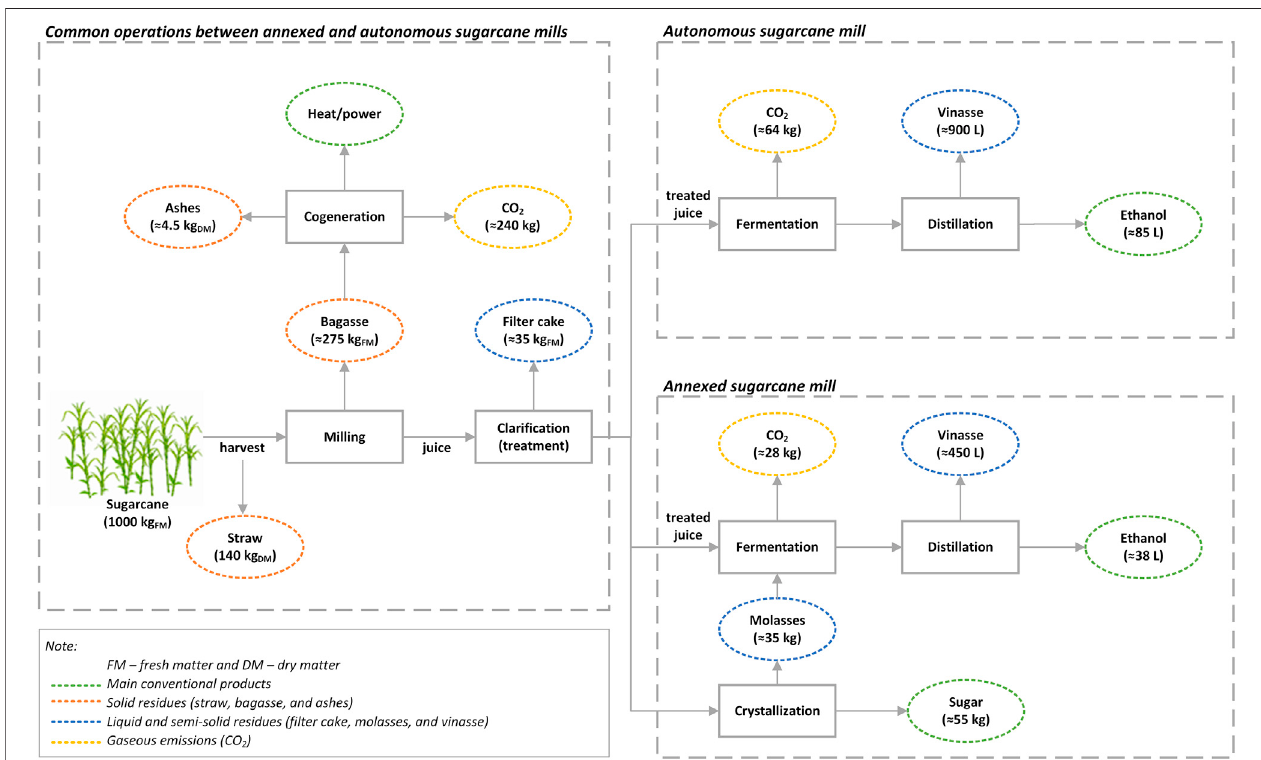
FIGURE 1 | Scheme of the sugar and bioethanol production process from sugarcane with the associated waste production.